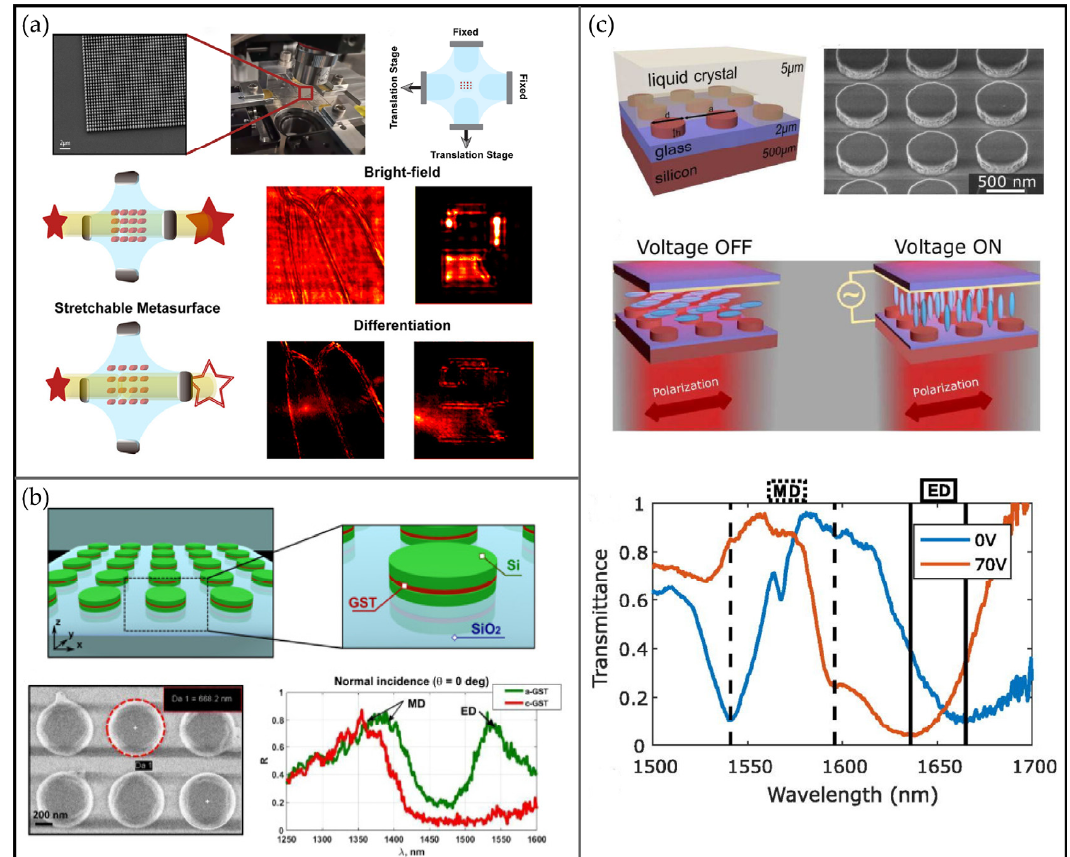
Figure 5. ( a ) A reconfigurable metasurface is composed of Si nanoposts embedded in PDMS, which achieves bright-field imaging and 2D differentiation images. Reprinted with permission from [93] .